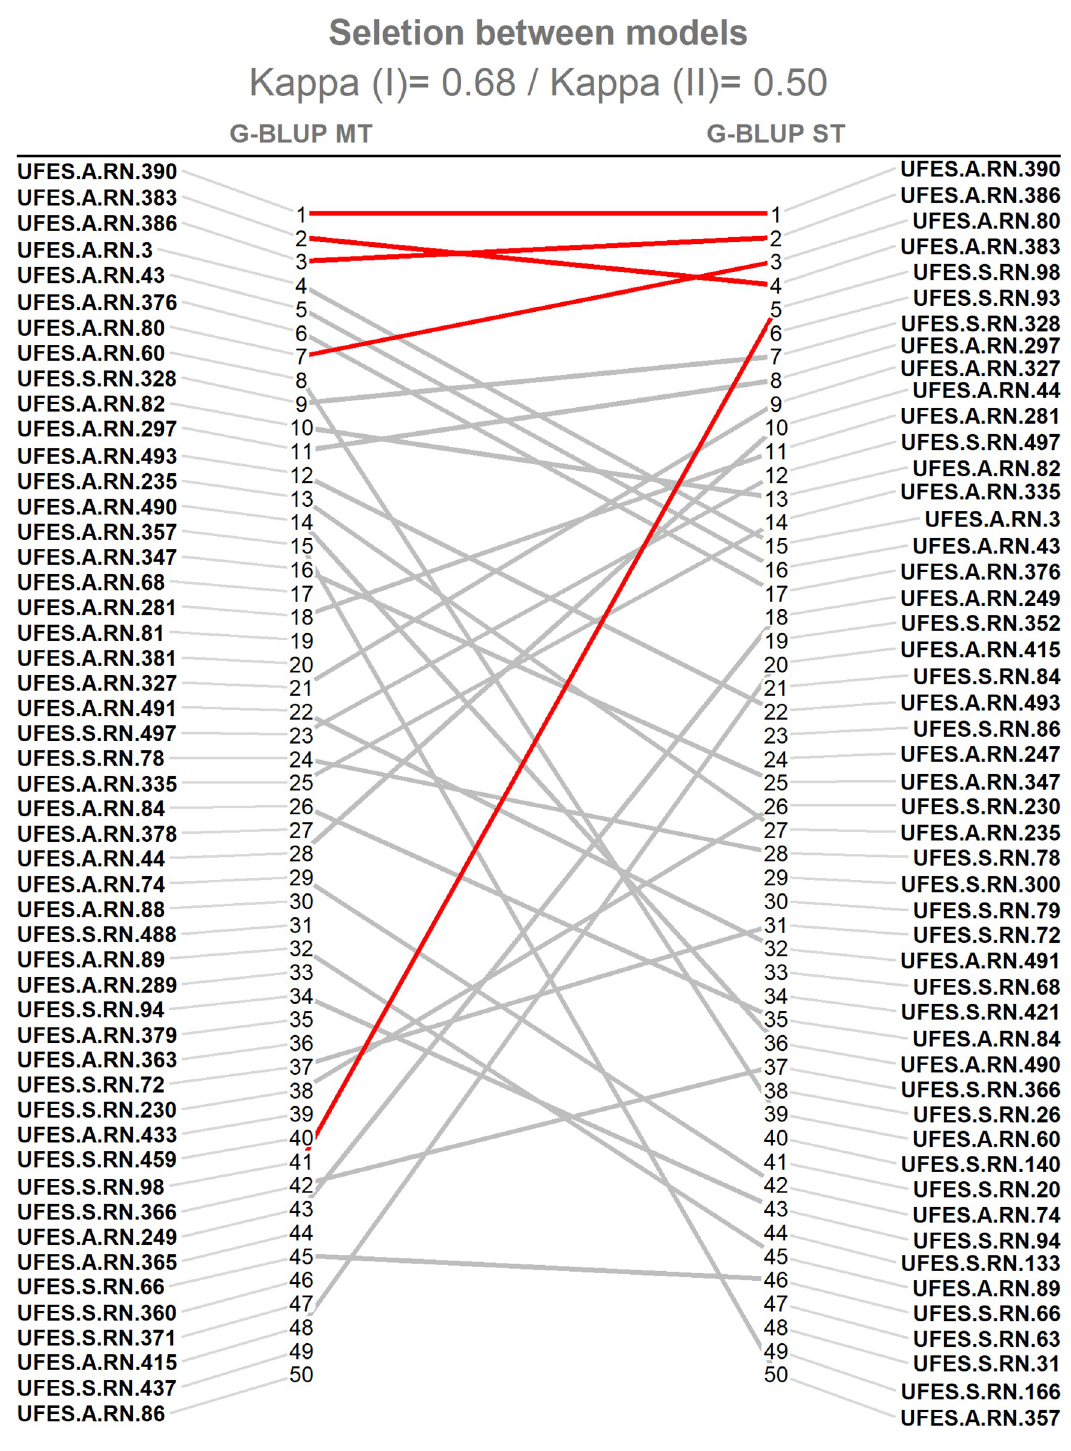
Fig 3. The agreement between genotypes selected by the G-BLUP MT and G-BLUP ST models. The Cohen’s Kappa coefficient showing the agreement between genotypes selected by the G-BLUP MT and G-BLUP ST models. Kappa (I) - 20% of the best genotypes (50 genotypes) and Kappa (II)—the six best genotypes selected (represented by red lines).